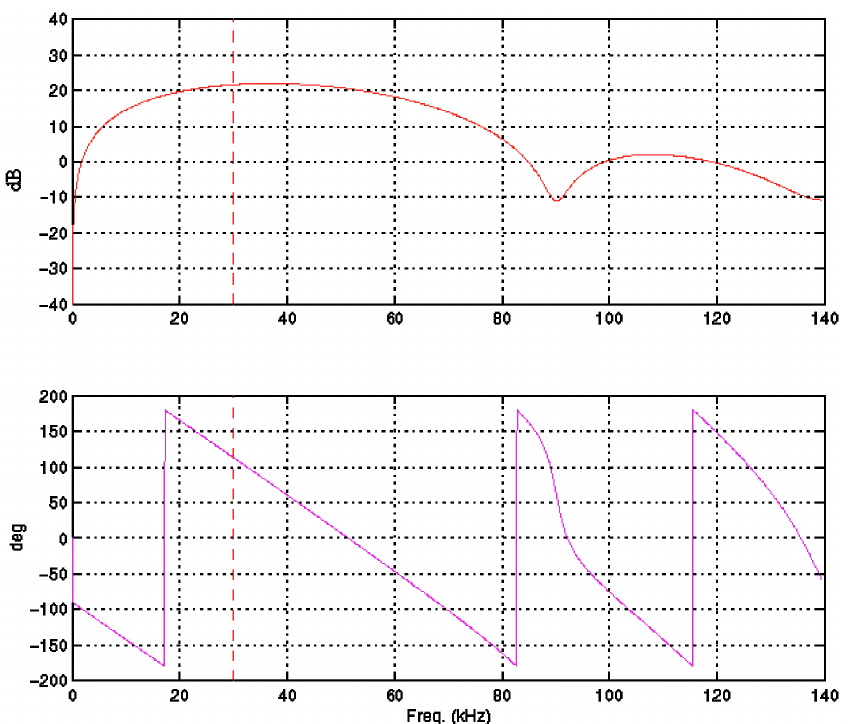
FIG. 4. (Color) Amplitude and phase response versus frequency of a FIR filter implemented in the DSP farm for high current electron beams. The synchrotron frequency is shown with the dotted line.